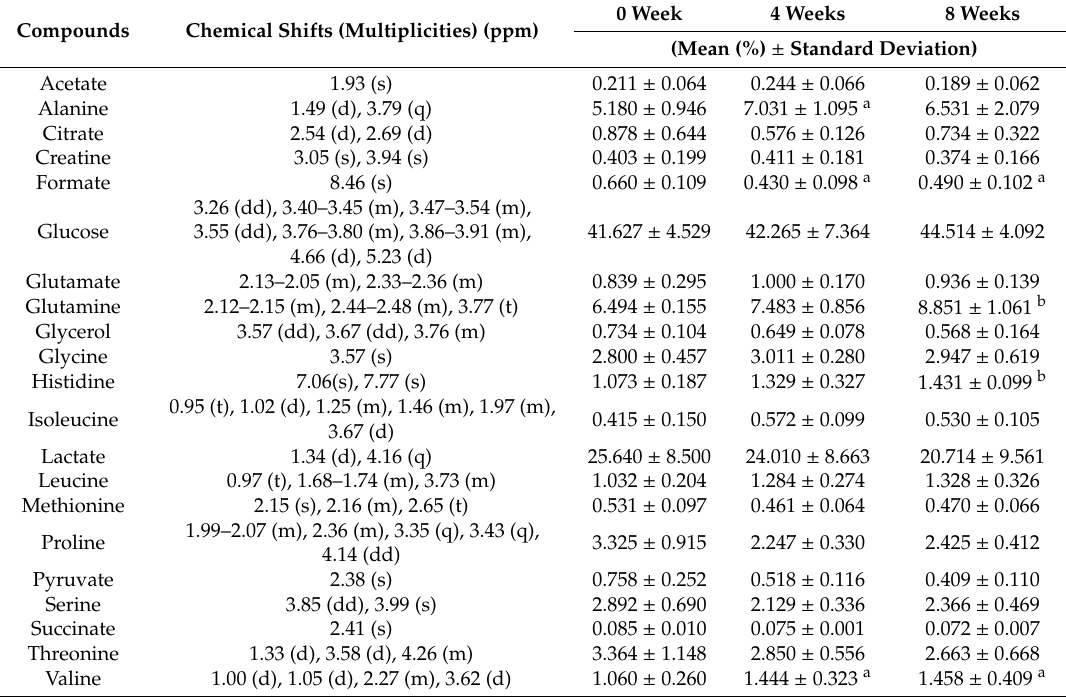
a Statistically different from 0 week with p -value < 0.05; b Statistically different from 0 week with p - value < 0.01.